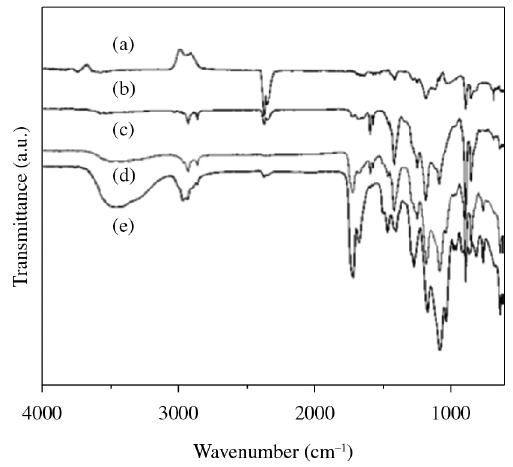
Figure 1. FTIR of neat polymer (a) PVDF and (e) PHEMA and electrolytes PVDF PHEMA/LiClO and (d)